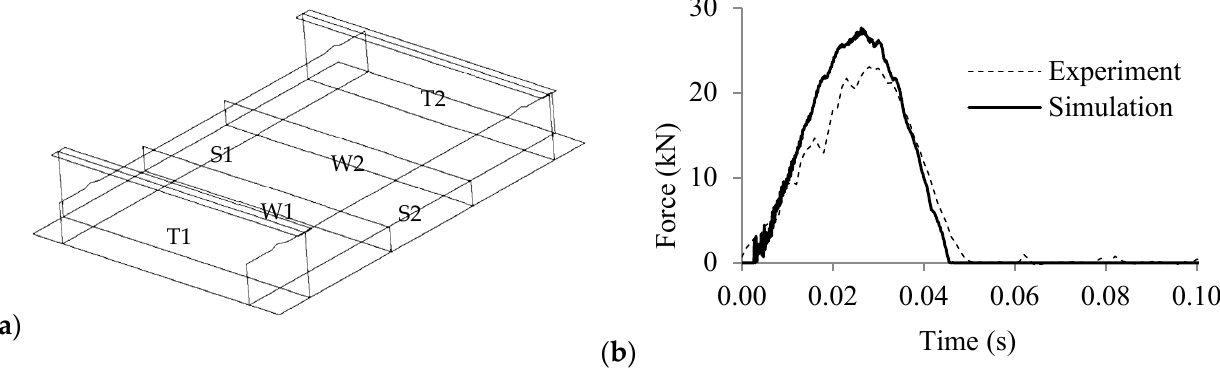
Figure 6. Comparison of experimental and FEM results. ( a ) The plate consists of two girders ( T 1 − 2 ), two stiffeners ( S 1 − 2 ) and two web frames ( W 1 − 2 ), ( b ) force–time evolution chart.